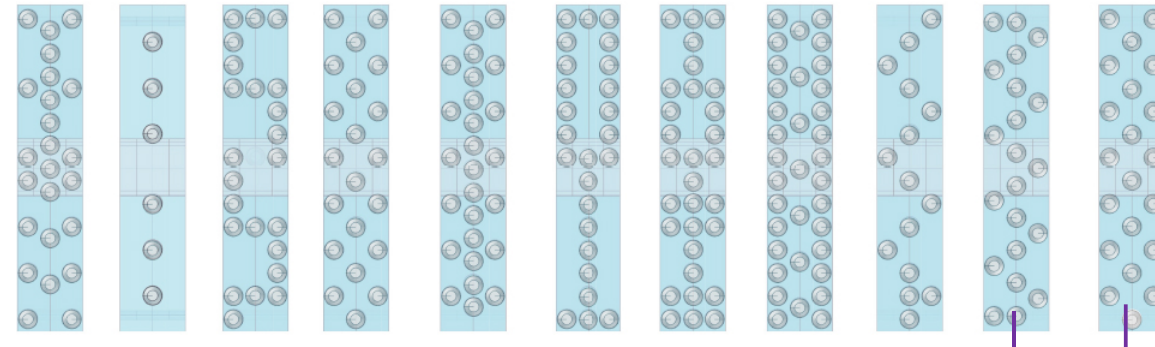
Fig. 11: The behaviour of those panels was assessed with FEA